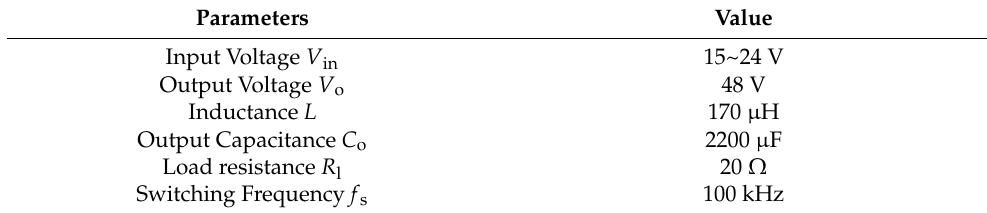
Table 1. Simulation parameters of Boost PFC converter. Parameters Value Input Voltage V